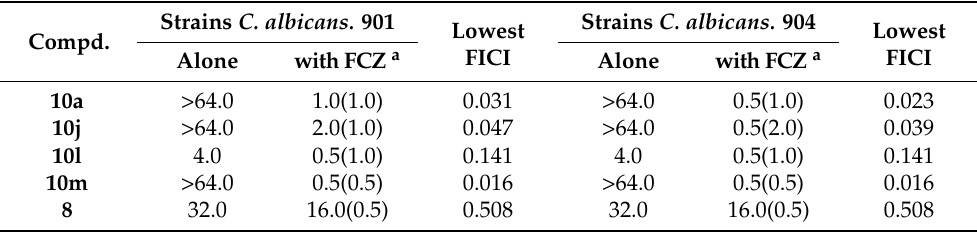
Table 2. Checkerboard microdilution assay of the 1,3,5-triazines derivatives and FCZ (MIC 80 , µ g/mL, 48 h).